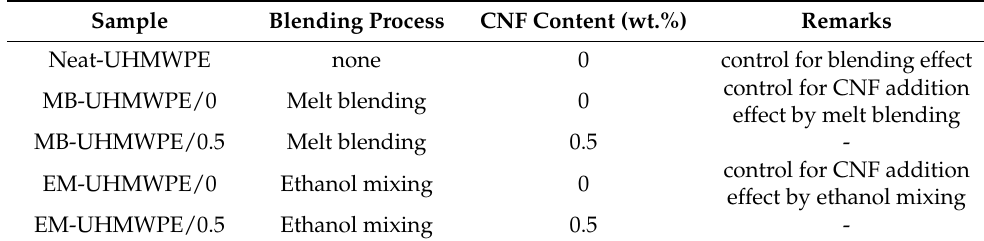
Figure 1. UHMWPE/CNF bionanocomposites by ethanol mixing. For comparison, UHMWPE/CNF bionanocomposite of same composition was melt blended by using triple screw kneading extruder at Kyushu Institute of Technology, Fukuoka, Japan with optimized condition of 150 ◦ C and 60 rpm rotational speed [38]. Meanwhile, UHMWPE without filler was subjected to both blending process and denoted as MB-UHMWPE/0 and EM-UHMWPE/0. The summary of produced bionanocomposites is as presented in Table 1. Table 1. UHMWPE/CNF bionanocomposite samples and